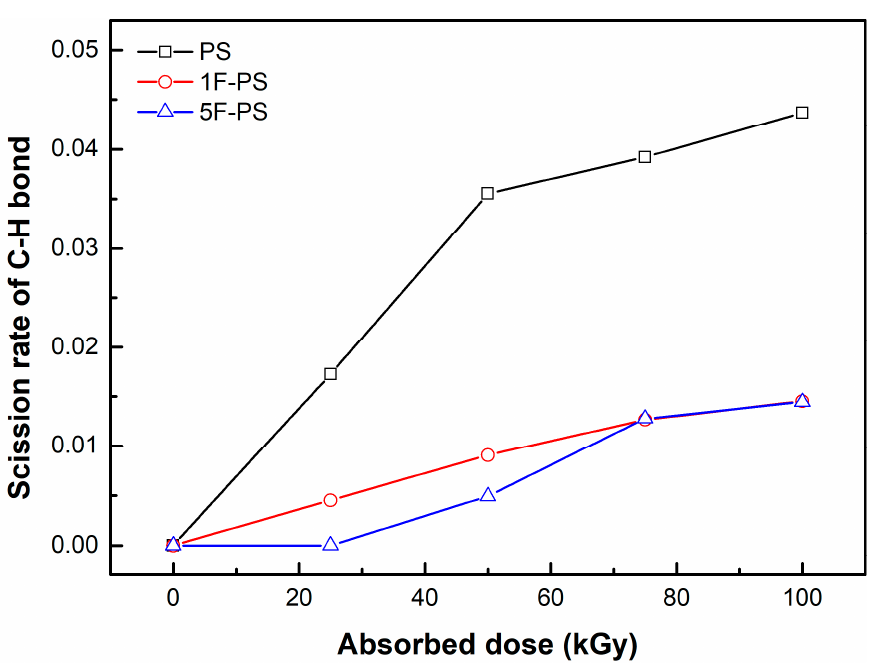
11 of 15 number: the ratio between the average molecular weight of atoms (experiment results) and atom number (simulation value) after irradiation. The scission rates of the bonds which were simulated in the polymers are shown in Figures 11–13. Figure 11. Scission rate of C-C bond of polymers. The scission rate of the C-C bond was the highest in the polystyrene. The value of the scission rate was increased sharply in the region of 25 to 50 kGy for polystyrene and 1F- PS and 50 to 75 kGy for 5F-PS. These results were similar with the maximum dissociation rate region, which were 3 (#/kGy) from 25 to 50 kGy at the polystyrene, 1.96 (#/kGy) from